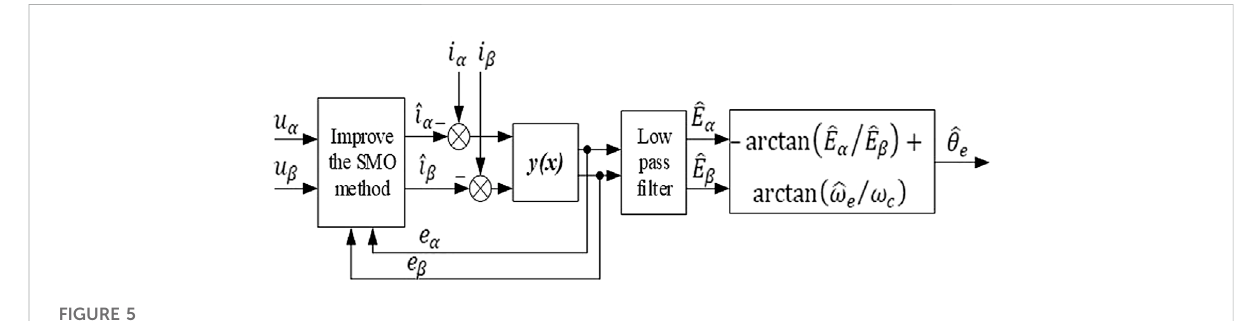
FIGURE 5 Block diagram of the improved SMO.